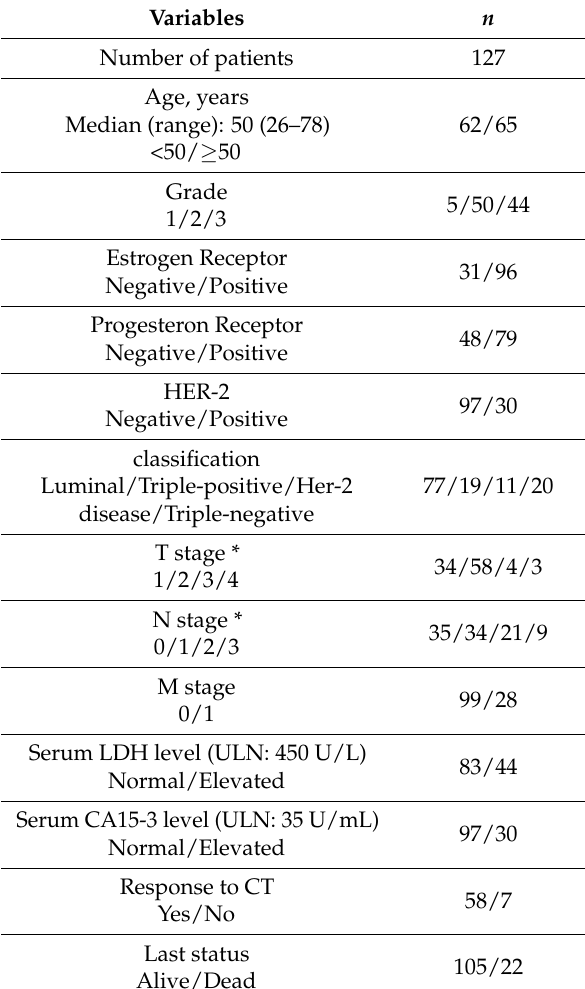
Table 1. Characteristics of the patients and disease.